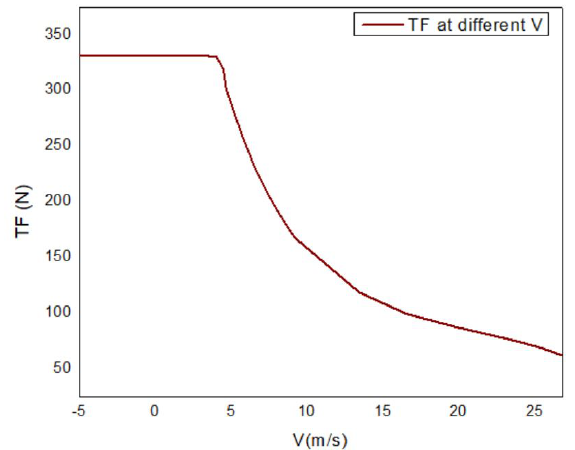
Figure 21. TF at different